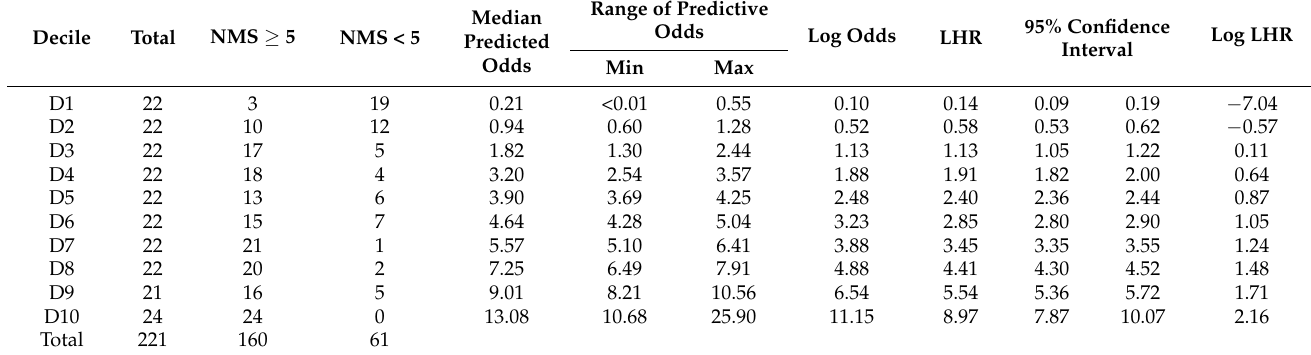
Table A1. Predicted odds and likelihood ratio (LHR) in discriminating 1-year postoperative ambula- tory status at each decile from preoperative model’s predictive